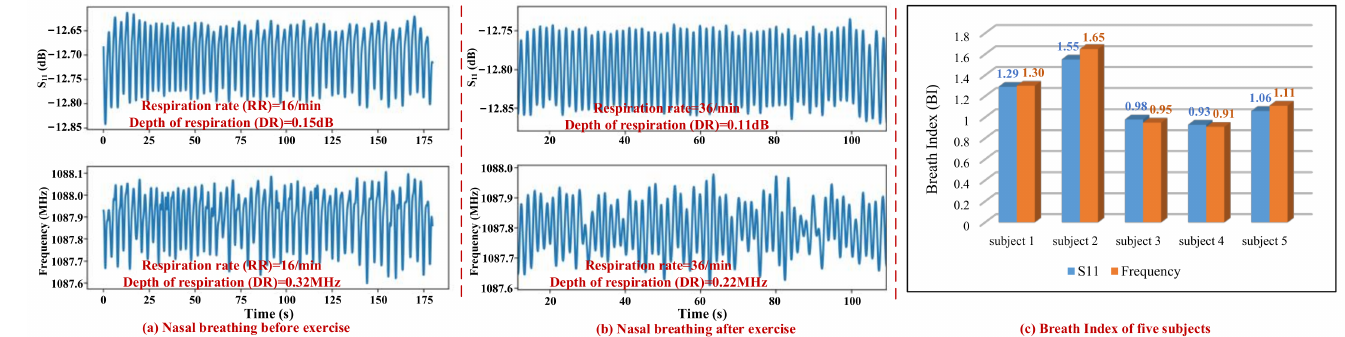
Figure 12. S 11 and frequency responses of subject 2 with nasal breathing ( a ) before and ( b ) after climbing six floors; ( c ) Calculated Breath Index (BI) of five